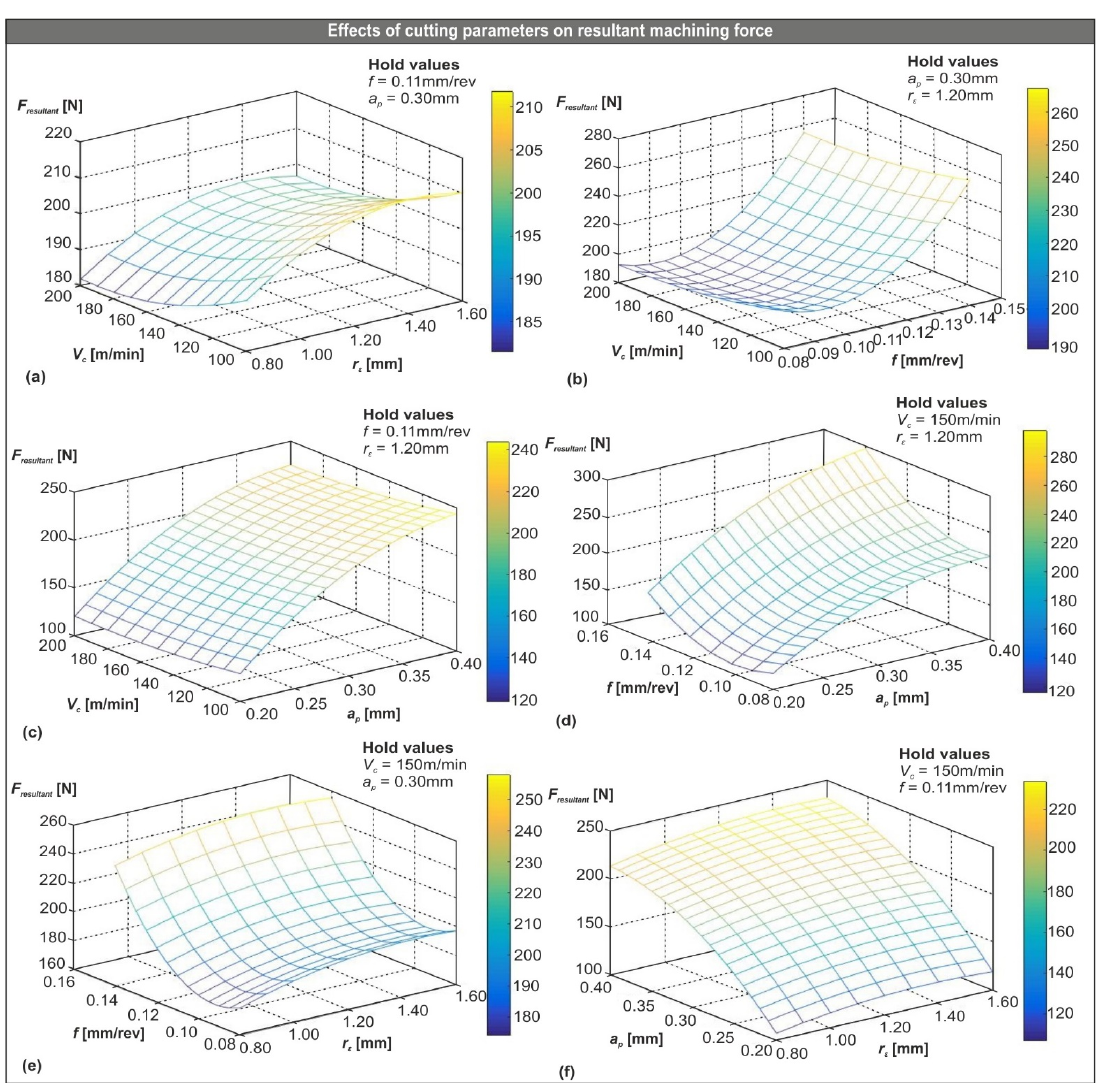
Figure 7. 3D surface plots: ( a ) F resultant vs. V c , r ε , ( b ) F resultant vs. V c , f , ( c ) F resultant vs. V c , a p , ( d ) F resultant vs. f , a p , ( e ) F resultant vs. f , r ε and ( f ) F resultant vs. a p , r ε .